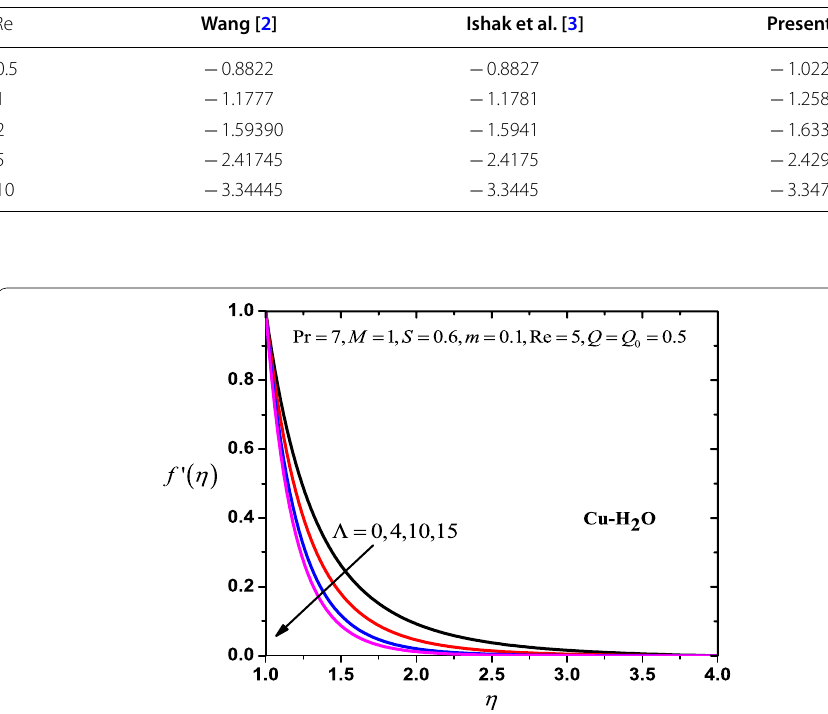
Fig. 2 Velocity versus (cid:31)